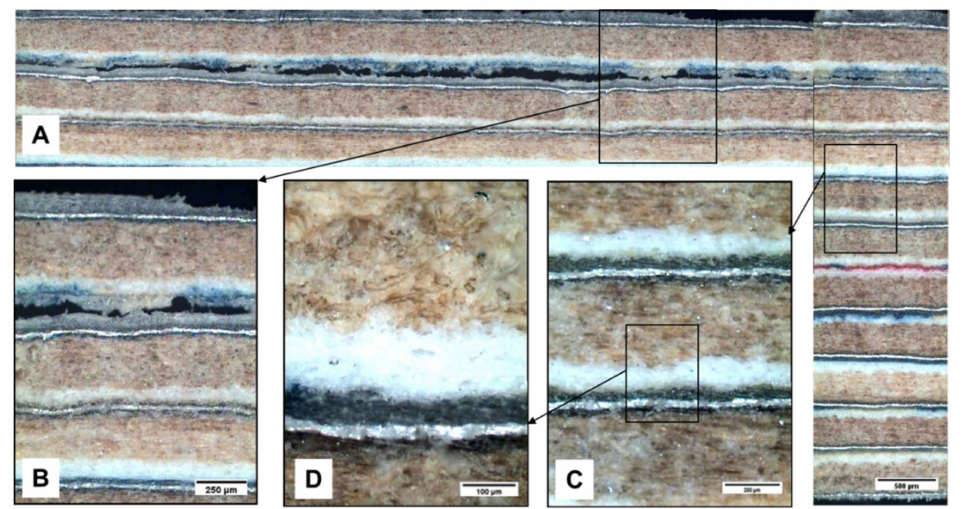
Figure 19. Lack in adhesion post-processing. ( A ) Micrographic mapping longitudinal—transversal of the board. ( B ) Detail area without adhesion PE–PE. ( C ) and ( D ) details into board, where a good binding between sheets is